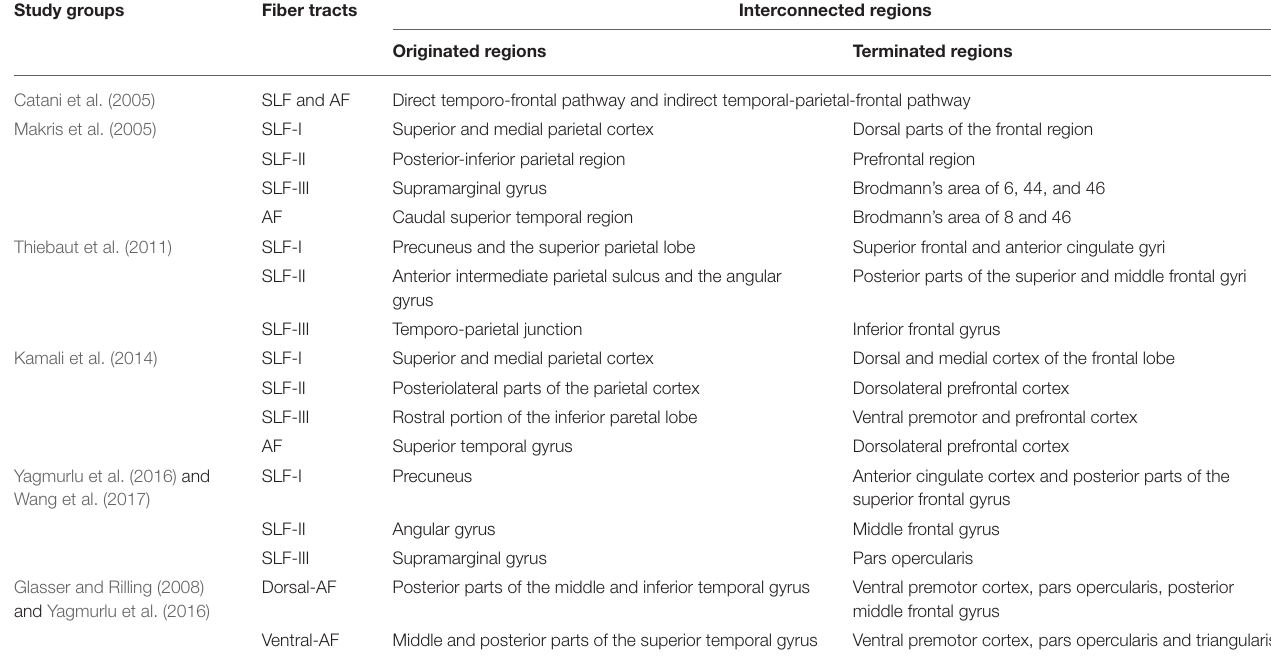
TABLE 1 | Contemporary and sometimes contentious models of the superior longitudinal fasciculus (SLF) and arcuate fasciculus (AF)